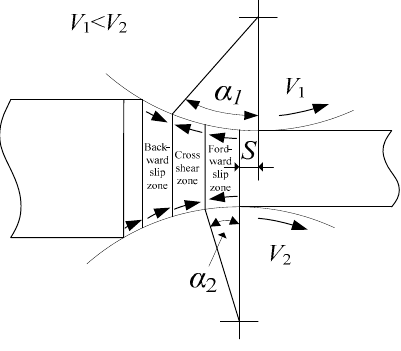
Figure 1. Schematic diagram of asymmetrical shear rolling ( V 1 : Velocity of upper roll; V 2 : Velocity of lower roll; S : Offset distance; α 1 :Neutral angle of upper roll; α 2 :Neutral angle of lower roll).